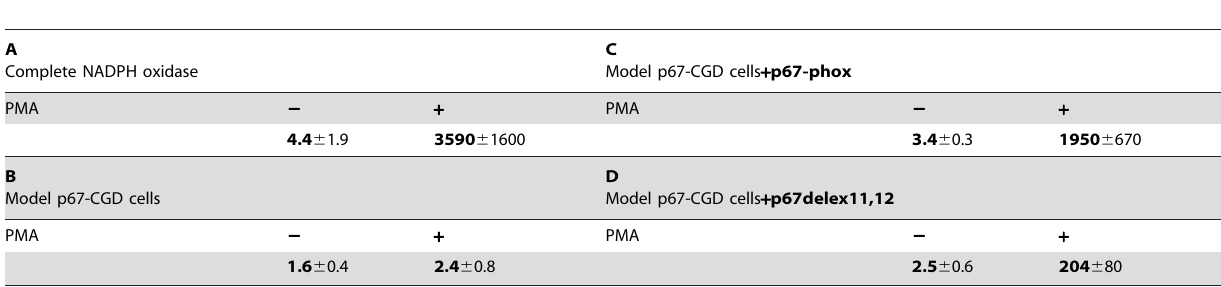
Table 4. NADPH oxidase with p67delex11,12 instead of complete p67-phox yields ROS.